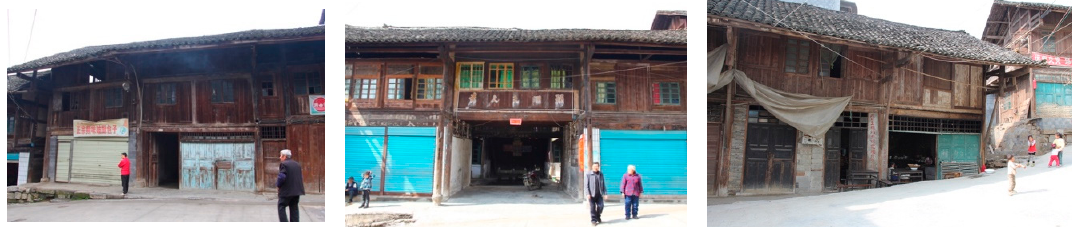
Figure 2. Typical vernacular courtyard houses in the same region as the selected structure.